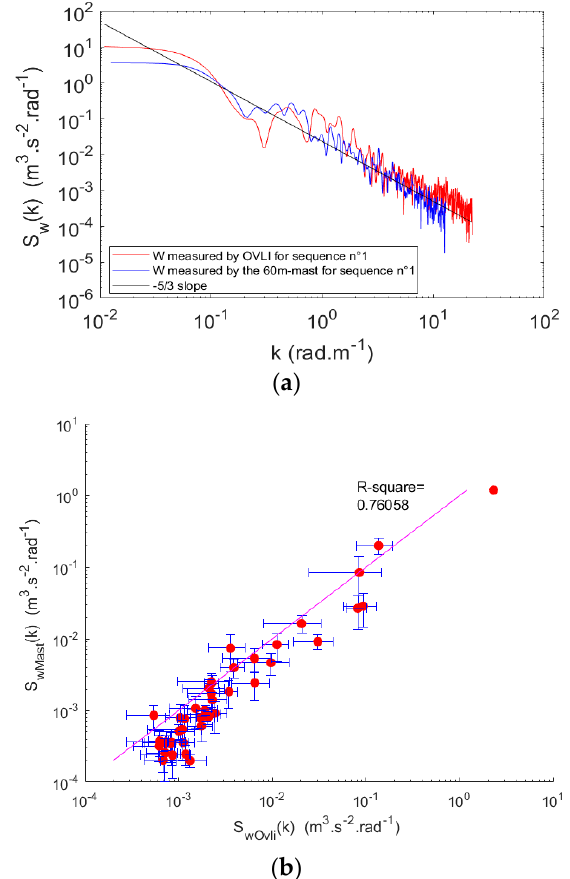
Figure 17. ( a ) Vertical wind spectrum as a function of wavenumber computed during the first straight sequence. OVLI-TA measurements are in red and the corresponding 60 m tower in blue. The spectra are computed using Welch’s method. ( b ) The scatter plot of the power density of the mast against OVLI-TA.